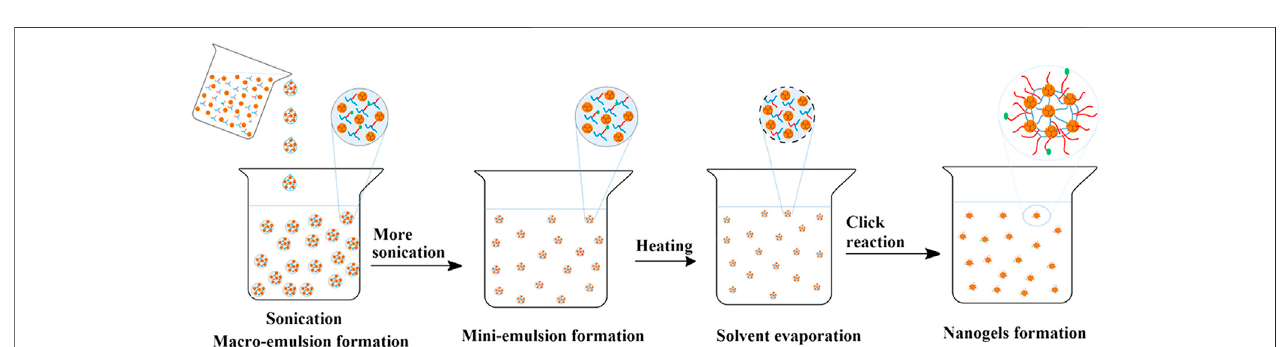
FIGURE 1 | Schematic illustration of the mini-emulsion technique (Abandansari et al., 2014). Copyright (2014) Elsevier.